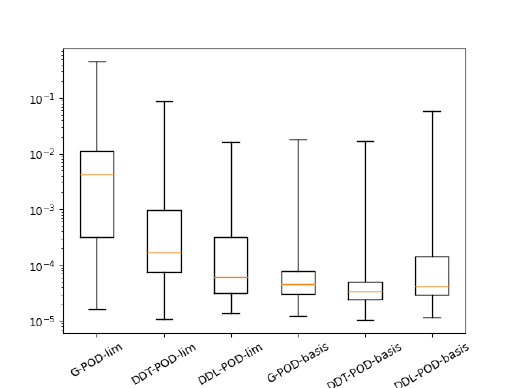
( b ) Boxplot of the error in k eff vs. the methods with the lim- ited number of snapshots and smart selection of the number of basis functions. Figure 18. Boxplots showing the errors for methods with the limited number of snapshots and smart selection of the number of basis functions. The median is given by the orange line, the interquartile ranges by the box and the minimum and maximum values by